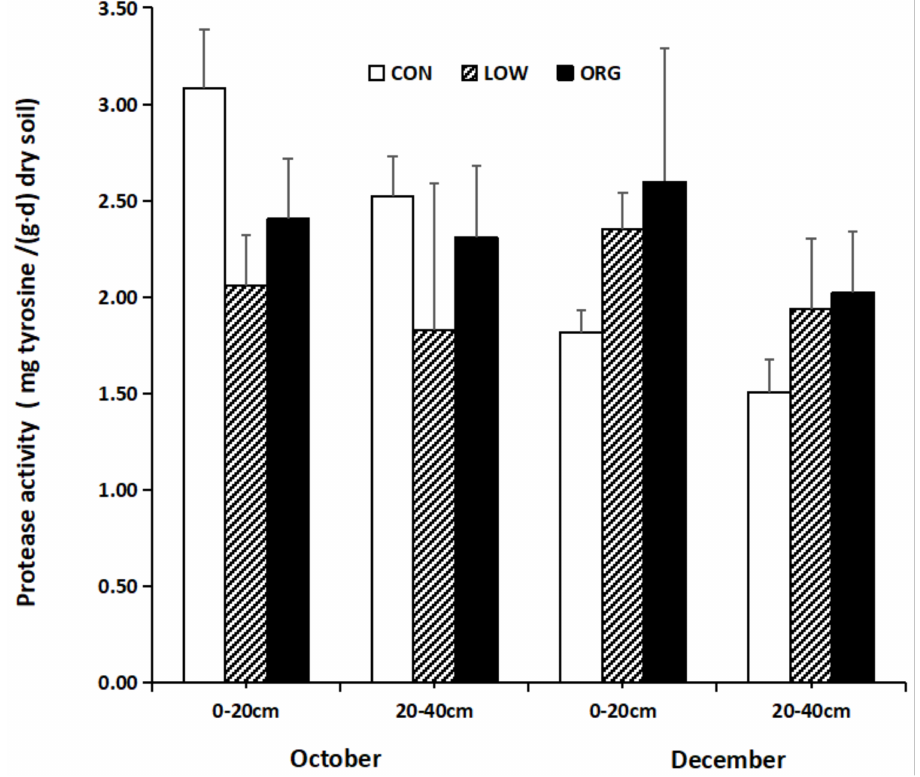
Figure 3. Effect of conventional, low-input, and organic practices on soil protease